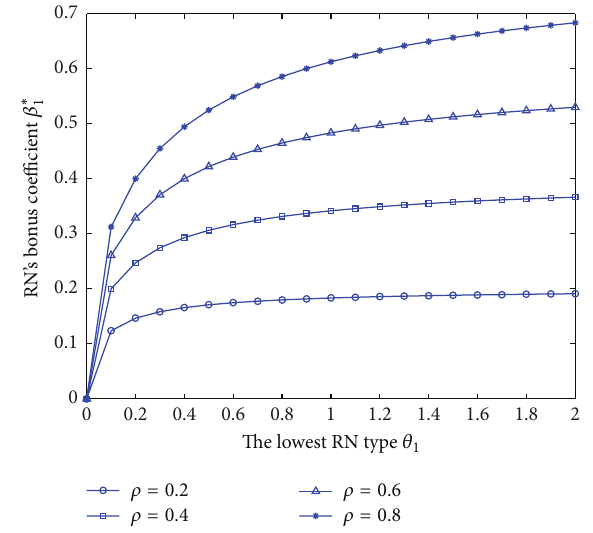
Figure 4: RNs’ optimal basic wage 𝛽 ∗ 1 versus the lowest RN type 𝜃 1 for fixed 𝑁 1 = 2 and 𝑈 = 0.1